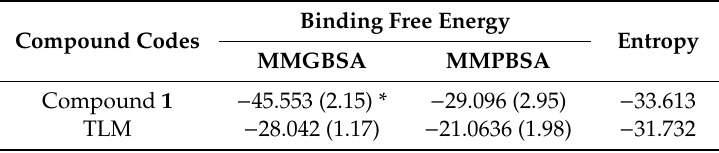
Figure 5. ( A ) Time dependent RMSD of the α -carbon atom for ApoKasA, KasA bound with TLM, and KasA bound with the compound 1 . The simulation was run for 200 ns. ( B ) Per-residue changes in root mean square deviation (RMSD) during 200 ns of simulation. The X -axis represents the residue number and the Y -axis is the RMSD of the α -carbon atom. The color blue, orange and grey represents the structures of ApoKasA, KasA bound with TLM, and KasA bound with the compound 1 , respectively. MM(GB / PB)SA was used to calculate the binding free energy (Table 4). The results suggest that compound 1 has lower free energy as compared with TLM. The calculated free energy and the observed molecular dynamic changes suggest strong binding of compound 1 with mycobacterial CasA. Table 4. MM(GB / PB)SA binding free energy and entropy (kcal / mol) for compound 1 and